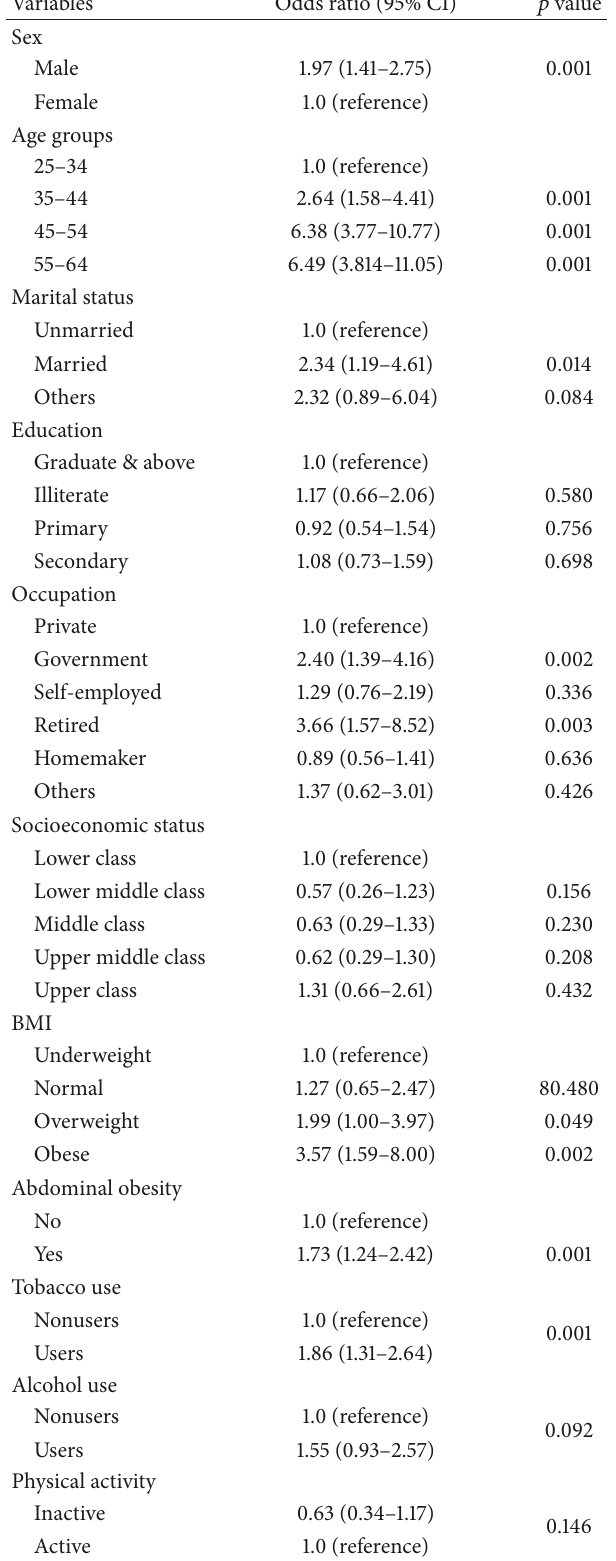
Table 6: Univariate analysis for the association of hypertension and sociodemographic characteristics, anthropometric measurements, and behavioral risk factors ( 𝑁